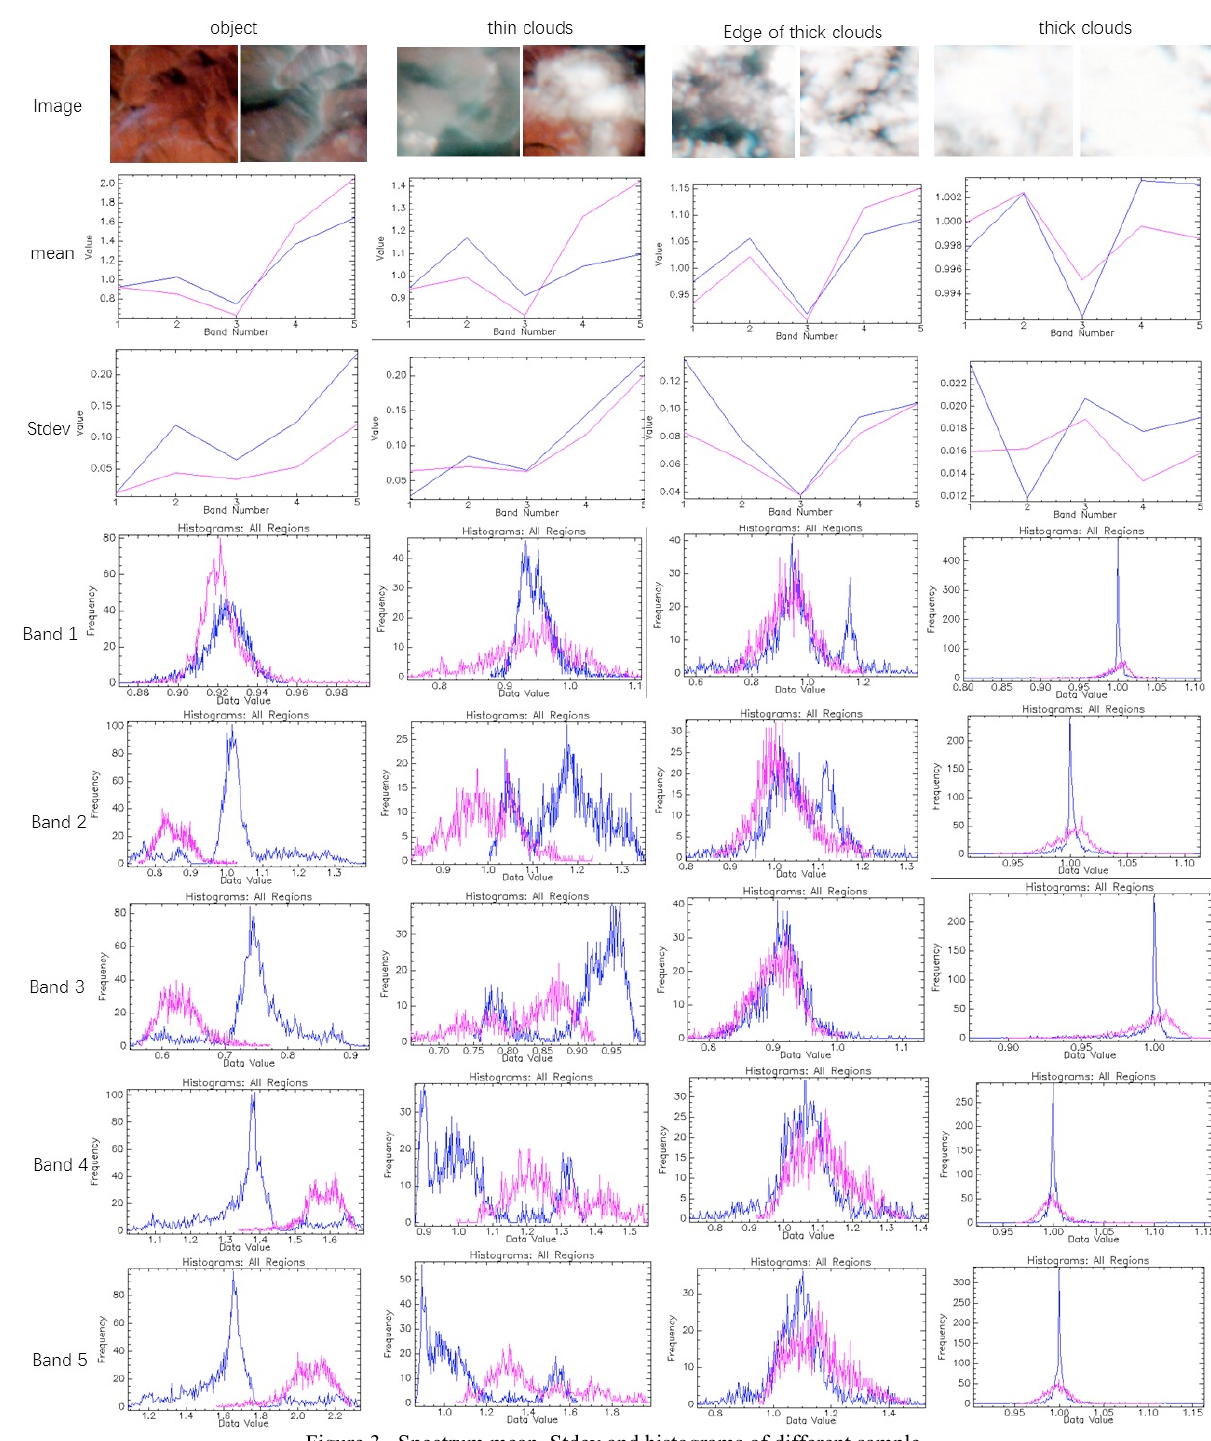
Figure 3. Spectrum mean, Stdev and histograms of different sample (The blue cuvees are the samples near to epicentre and the purple cuvees are samples in the other